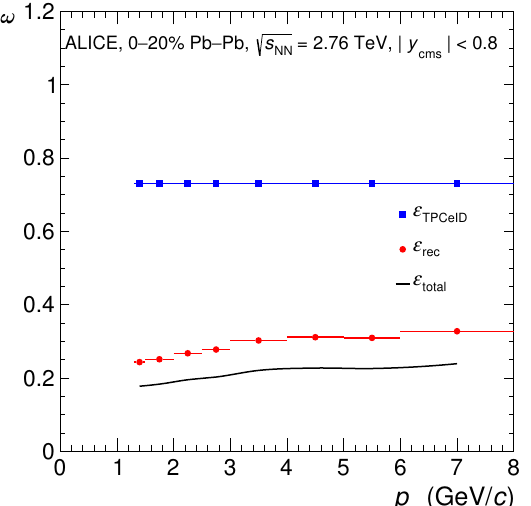
Figure 3 . E(cid:14)ciencies of the di(cid:11)erent track selection steps for the measurement in central Pb-Pb